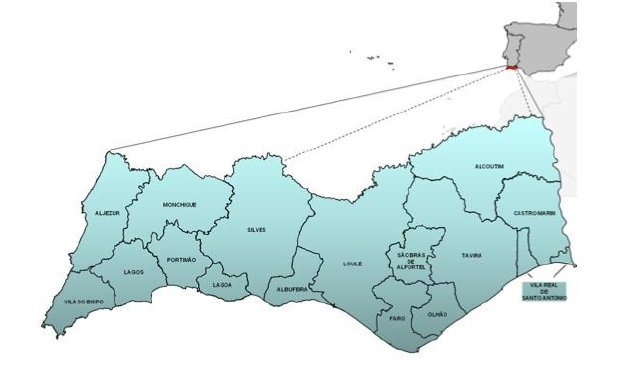
Figure 1: Algarve in Portugal and Europe